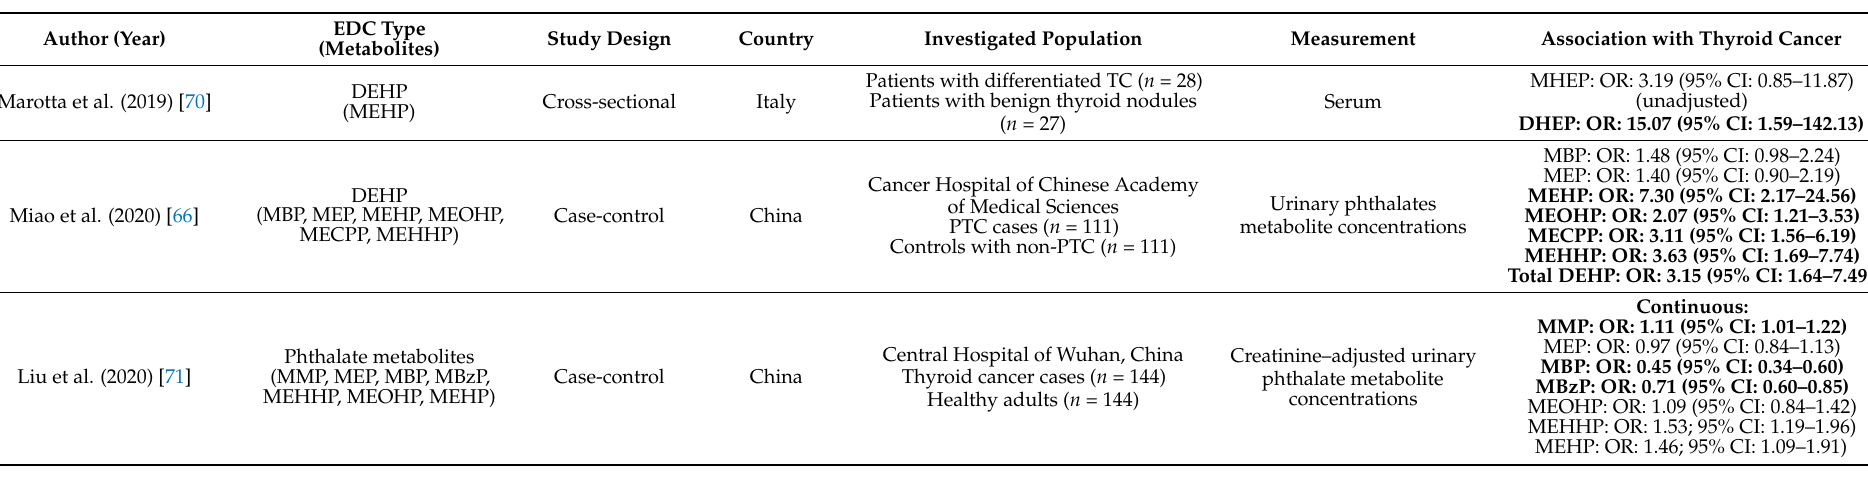
Table 3. Association between exposure to phthalates and thyroid cancer. Abbreviations: CI: confidence interval; DEHP: di(2-ethylhexyl)phthalate; EDC: endocrine disrupting chemicals;